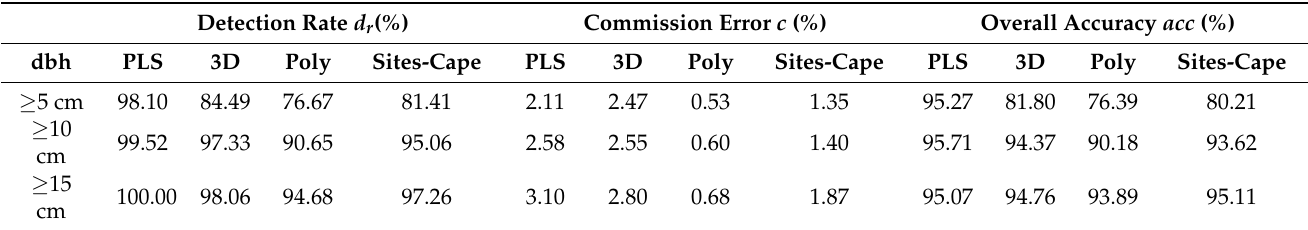
Table A3. Detection rates, commission errors, and overall accuracies for PLS/iPad and lower dbh